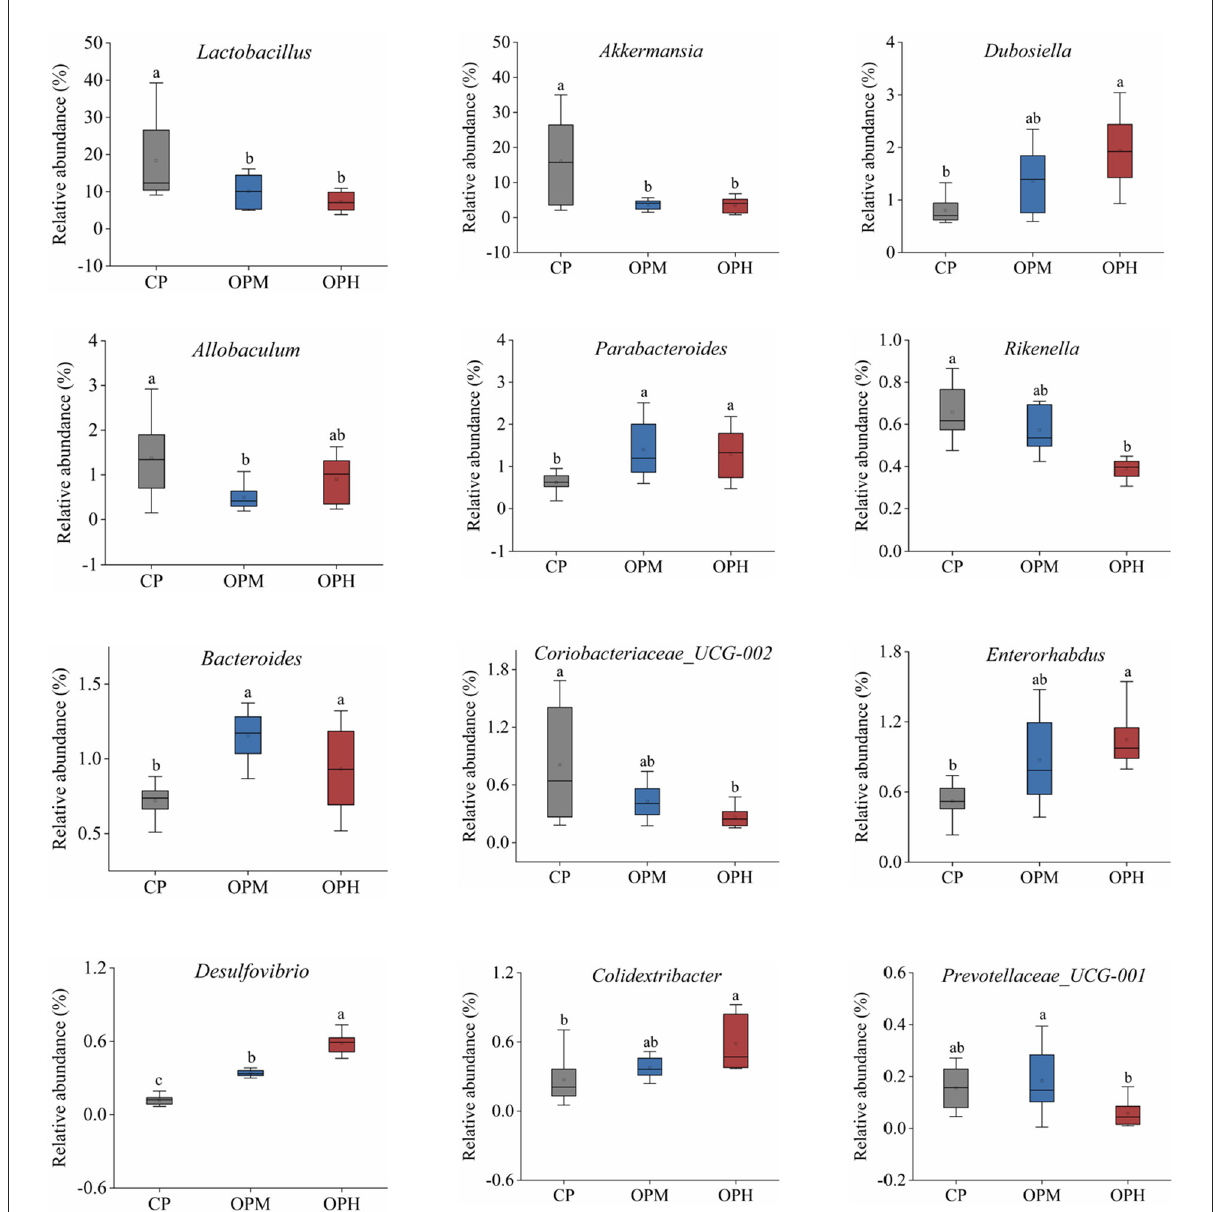
FIGURE4 Effects of consuming oxidized beef protein on GM composition at the genus level. Different letters (a-c) represent significant differences ( p < 0.05). The results of were expressed in box plot with whisker bar ( n =